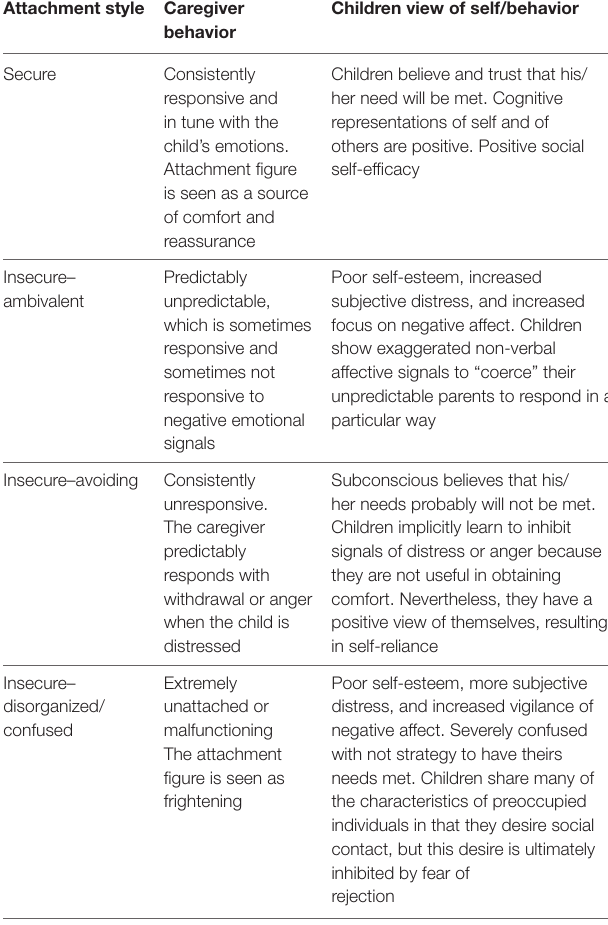
Table 1 | Attachment styles in